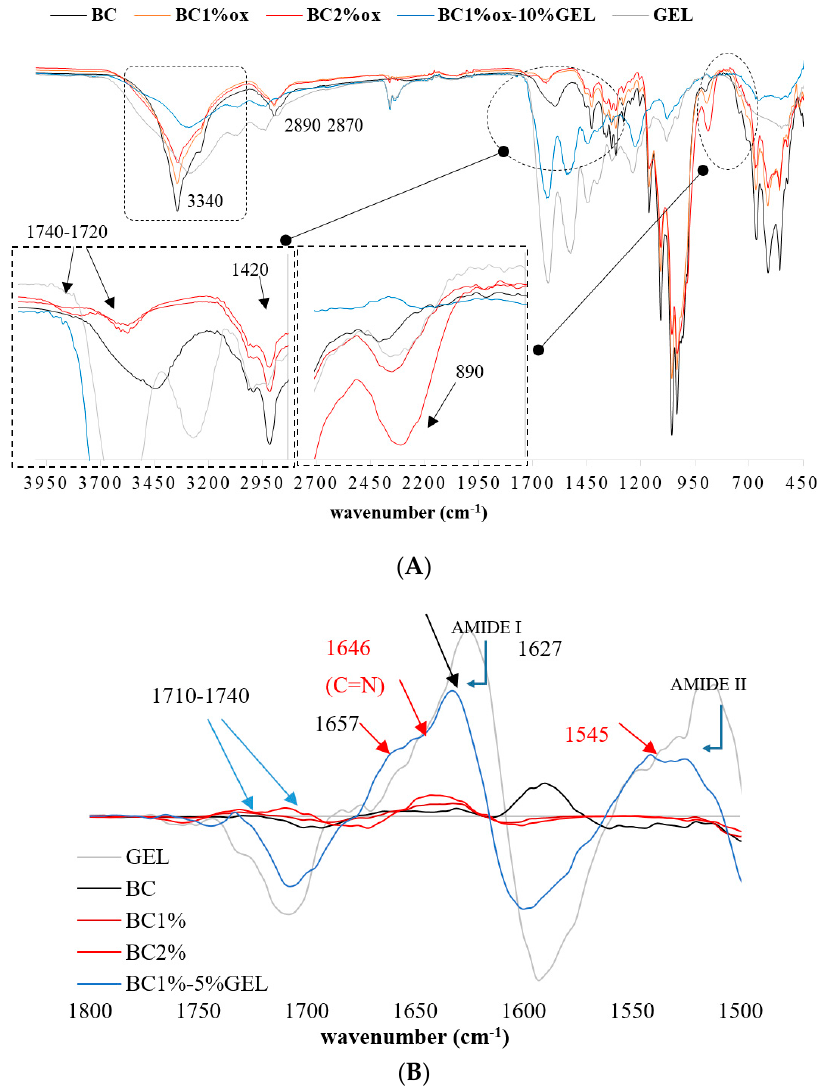
Figure 1. ( A ) Fourier Transform Infrared (FTIR) spectra of native, 1%, and 2% periodate-oxidized bacterial cellulose (BC) and BC1%ox–10%GEL (gelatin) and ( B ) FTIR spectra of the second derivative for the region between 1500 and 1800 cm − 1 .